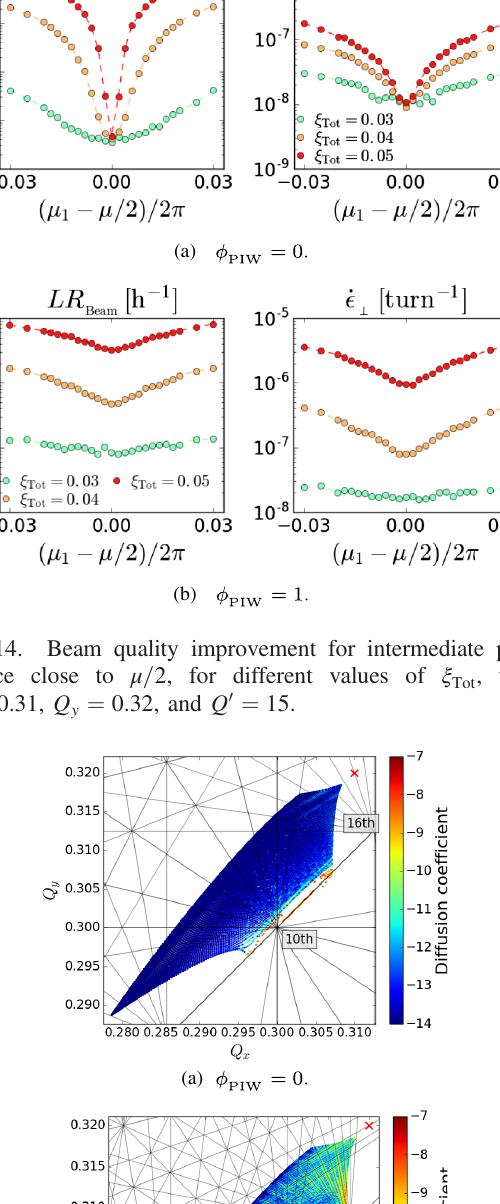
FIG. 15. FMA illustrating canceling of resonances using an intermediate phase advance μ 1 ¼ μ = 2 , for a working point of ð Q x ; Q y Þ ¼ ð 0 . 31 ; 0 . 32 Þ , Q 0 ¼ 0 and ξ Tot ¼ 0 . 03 . Possible reso- nance lines up to the 16th order have been added, in addition to a few labels meant to guide the